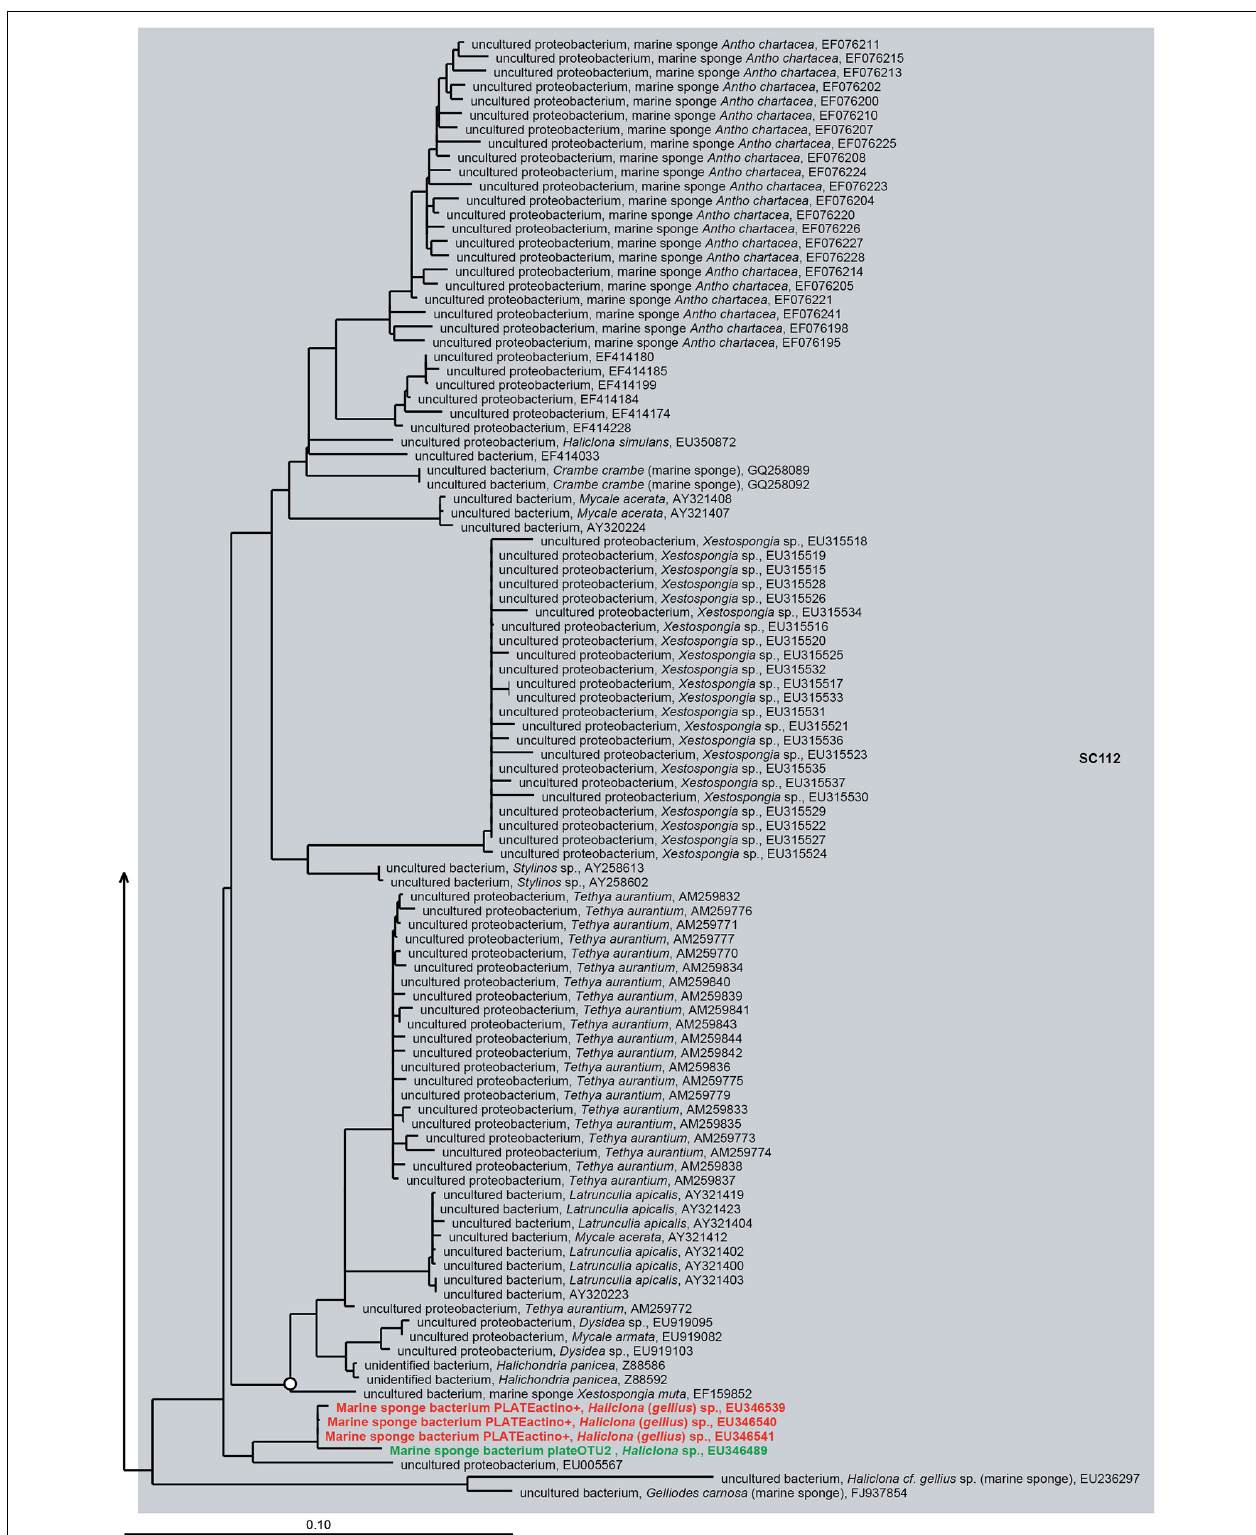
FIGURE 6 | 16S rRNA gene-based phylogeny of sponge-specific cluster SC112 within the Betaproteobacteria . Details are as provided for Figure 5 .